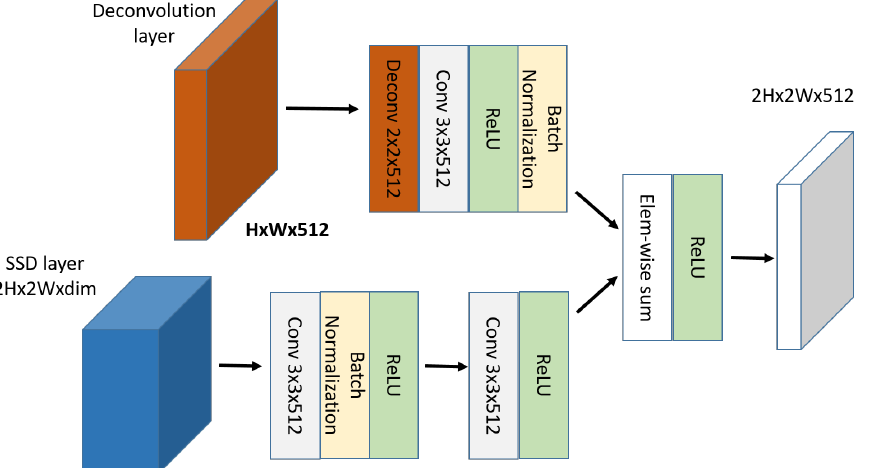
Figure 6. A deconvolutional module unit merged with an SSD layer using element-wise sum